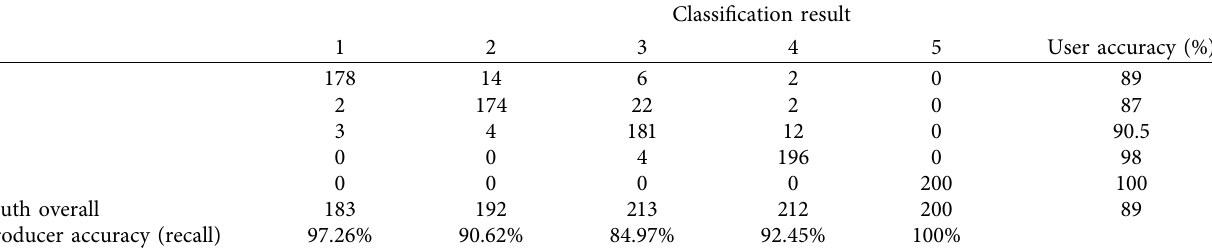
Table 6: RBR confusion matrix in